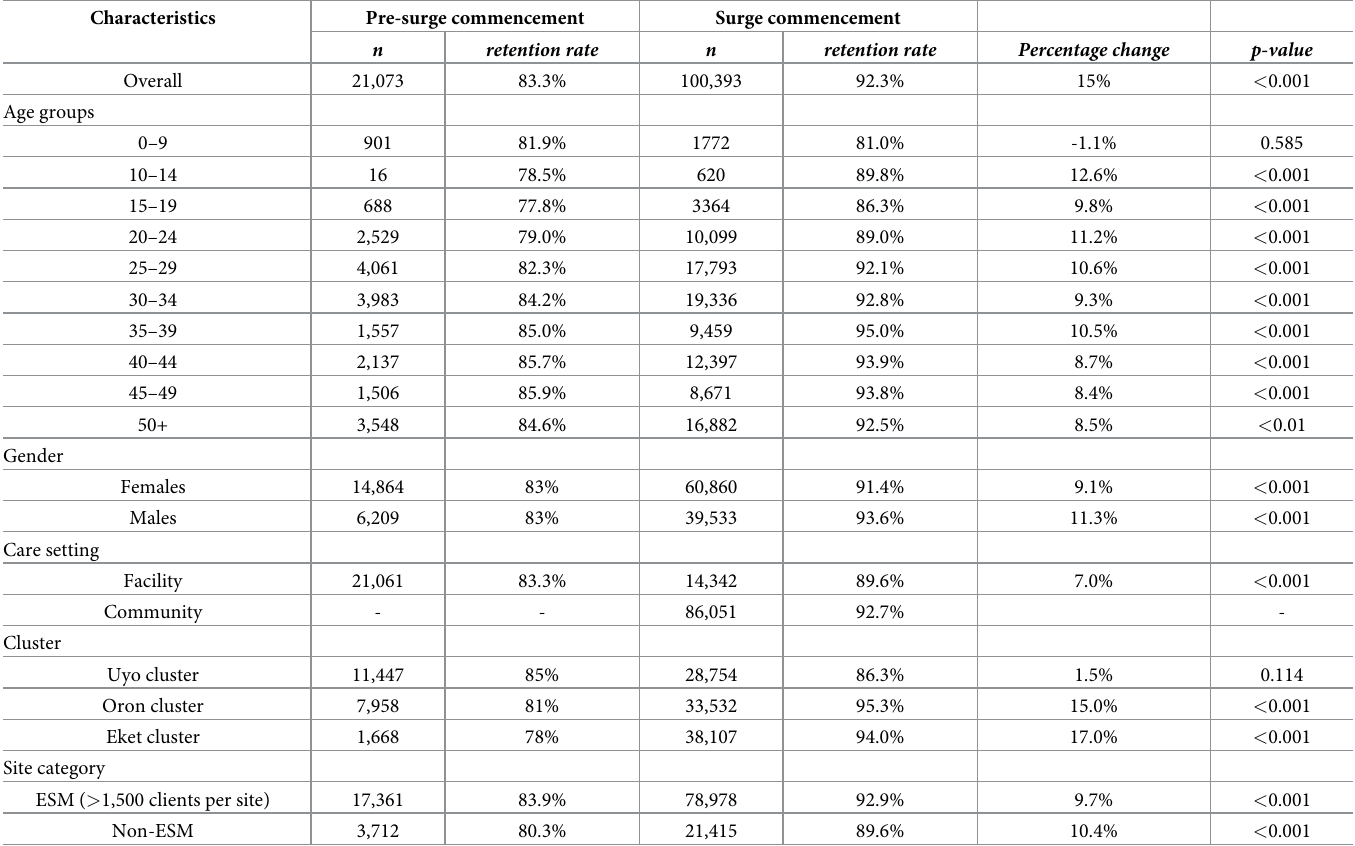
Table 6. Retention by intervention period and key client characteristics (April 2019–March 2021).